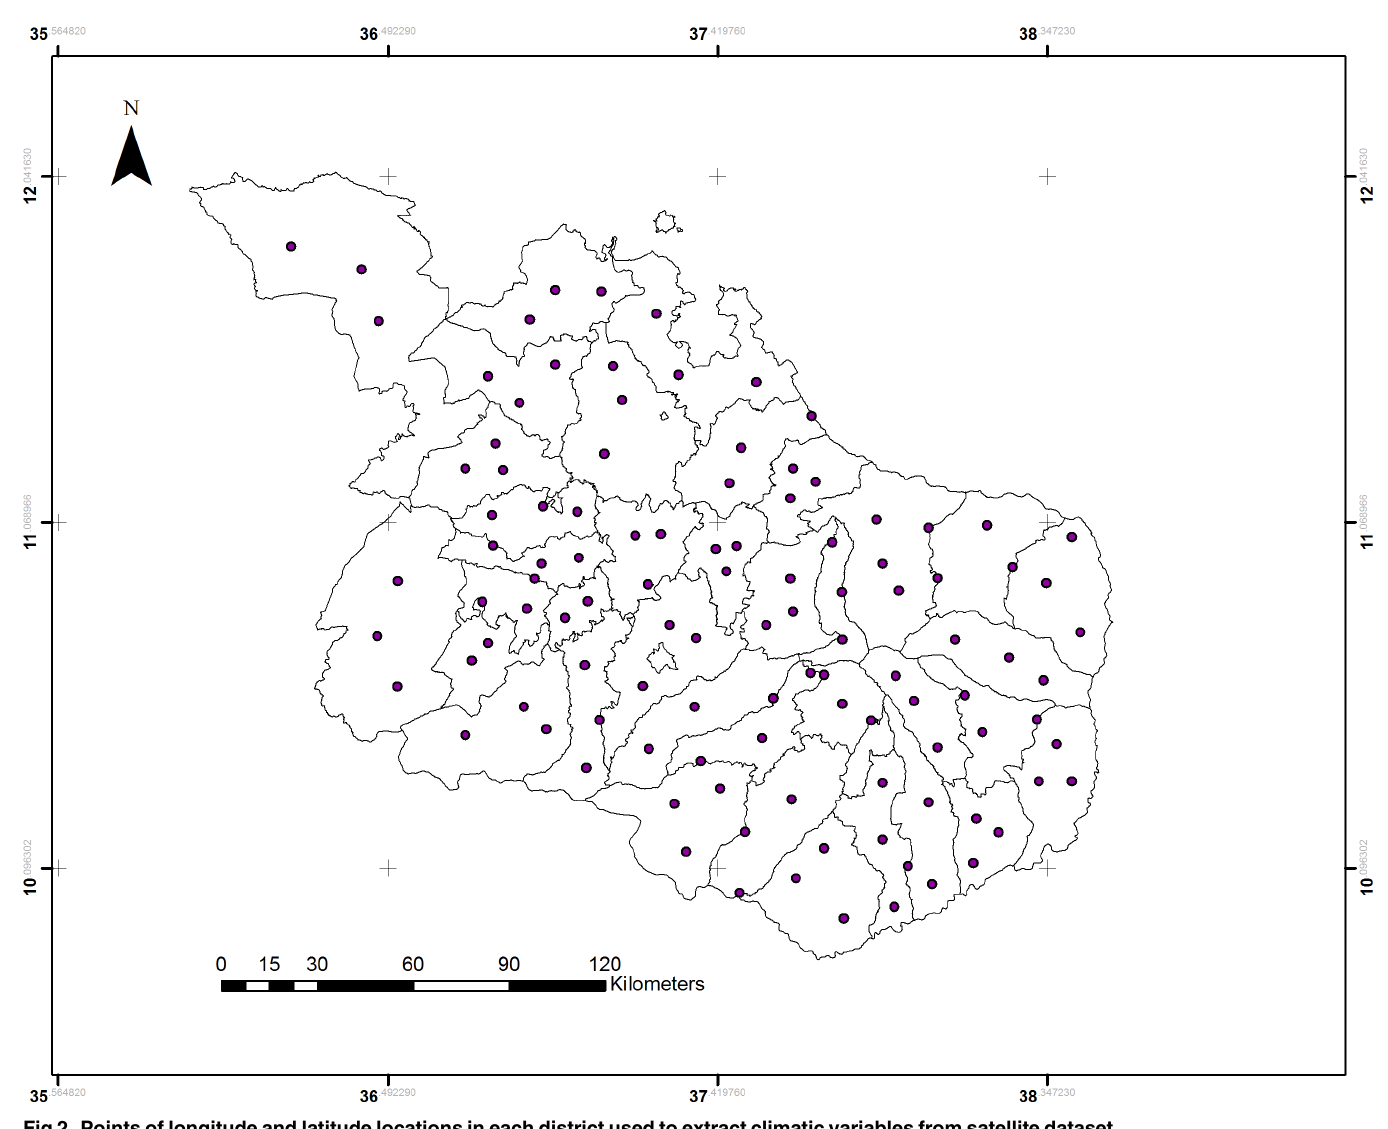
Fig 2. Points of longitude and latitude locations in each district used to extract climatic variables from satellite